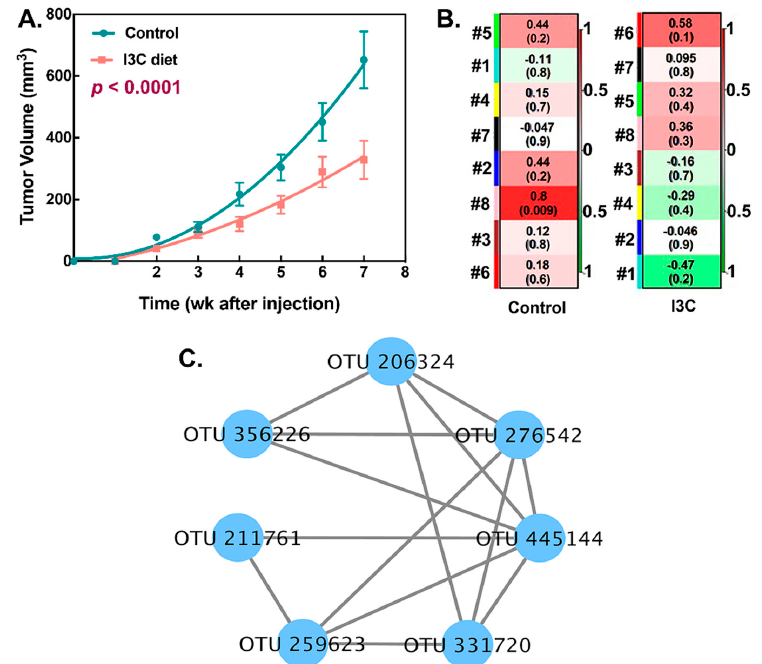
Figure 4. The relationship of network topology with environmental trait. ( A ) Effect of dietary I3C on tumor growth. (Mean tumor volume of tumors formed in control and I3C-treated mice during the 7-week treatment period after LNCaP human prostate cancer cell injection. The data obtained was analyzed by non-linear fitting and comparison of fits; two different curves were presented for each data set); ( B ) The correlation between module eigengene and tumor size (red color indicates a highly positive correlation and green color indicates a highly negative correlation. The numbers in each plot are the correlation coefficient (r) and significance ( p ) in parentheses); ( C ) The OTU composition of module 8 in the control group.